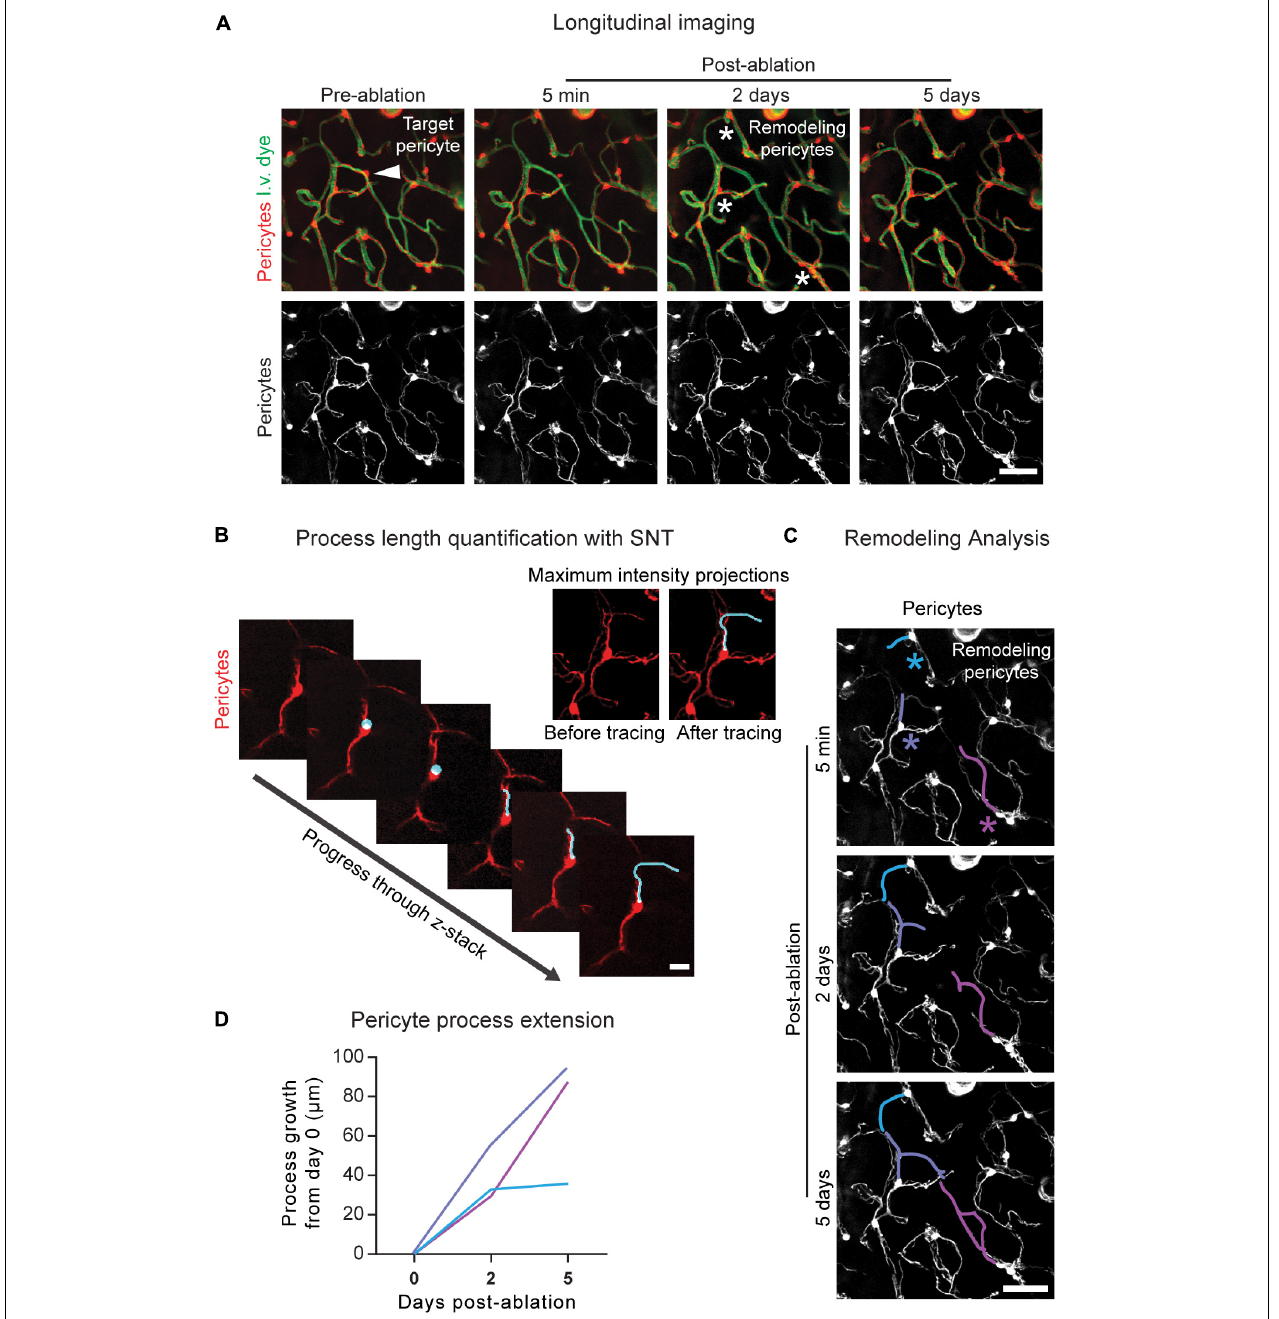
FIGURE 4 | Longitudinal imaging and analysis of pericyte structural remodeling. (A) Example of longitudinal imaging following pericyte ablation. The area is shown prior to pericyte ablation and 5 min, 2 days, and 5 days post-ablation. In the upper left image, the arrowhead indicates the targeted pericyte. In the upper third image from the left, the asterisks indicate the remodeling pericytes. Pericytes are shown in red, and vessels are shown in green. Scale bar = 50 µ m. (B) Pericyte length quantification in 3D using image z-stacks in ImageJ/FIJI. Using the SNT plugin, the process is traced from where it extends from the soma to its terminal tip. (Upper right) Maximum intensity projections of this pericyte process are shown prior to and following SNT analysis. Pericytes are shown in red. Scale bar = 15 µ m. (C) Pericyte remodeling measured over time. Using the SNT plugin in ImageJ/FIJI the baseline lengths of the processes are measured and the growth of each pericyte process is measured at 2 and 5 days post-ablation using the post-ablation z-stacks. The colored asterisks correspond to the colored process at each imaging timepoint. Pericytes are shown in greyscale. Scale bar = 50 µ m. (D) Quantification of pericyte remodeling. At each post-imaging timepoint, pericyte length is subtracted from pericyte length at baseline (day 0), and the resulting process growth in µ m is plotted. Line color corresponds to the process color in (C) .